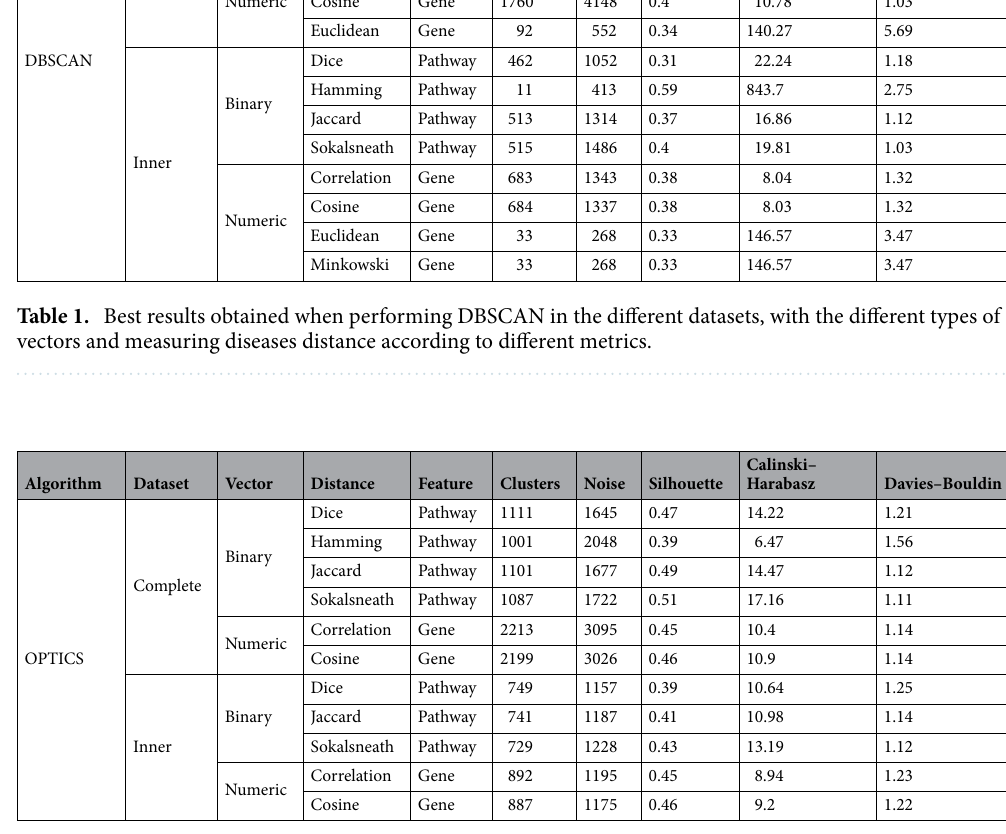
Table 2. Best results obtained when performing OPTICS in the different datasets, with the different types of vectors and measuring diseases distance according to different metrics.